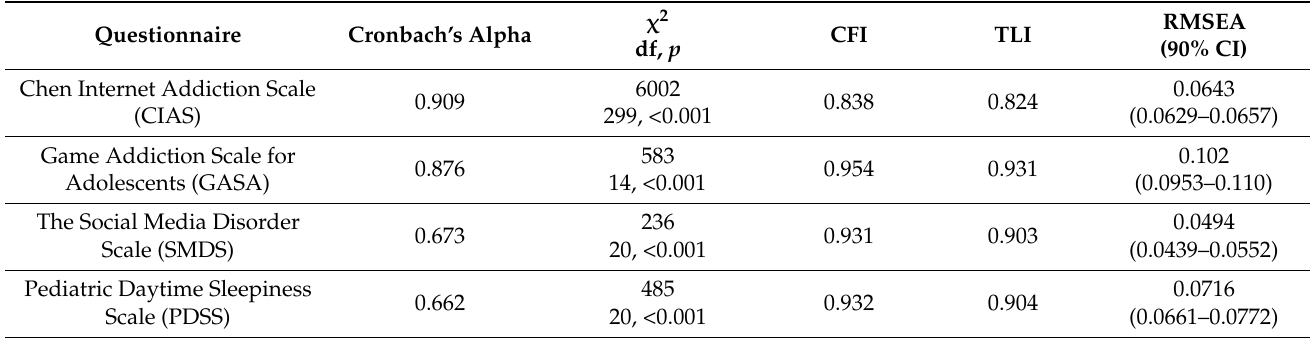
Table 2. Psychometric characteristics of the questionnaires included in the